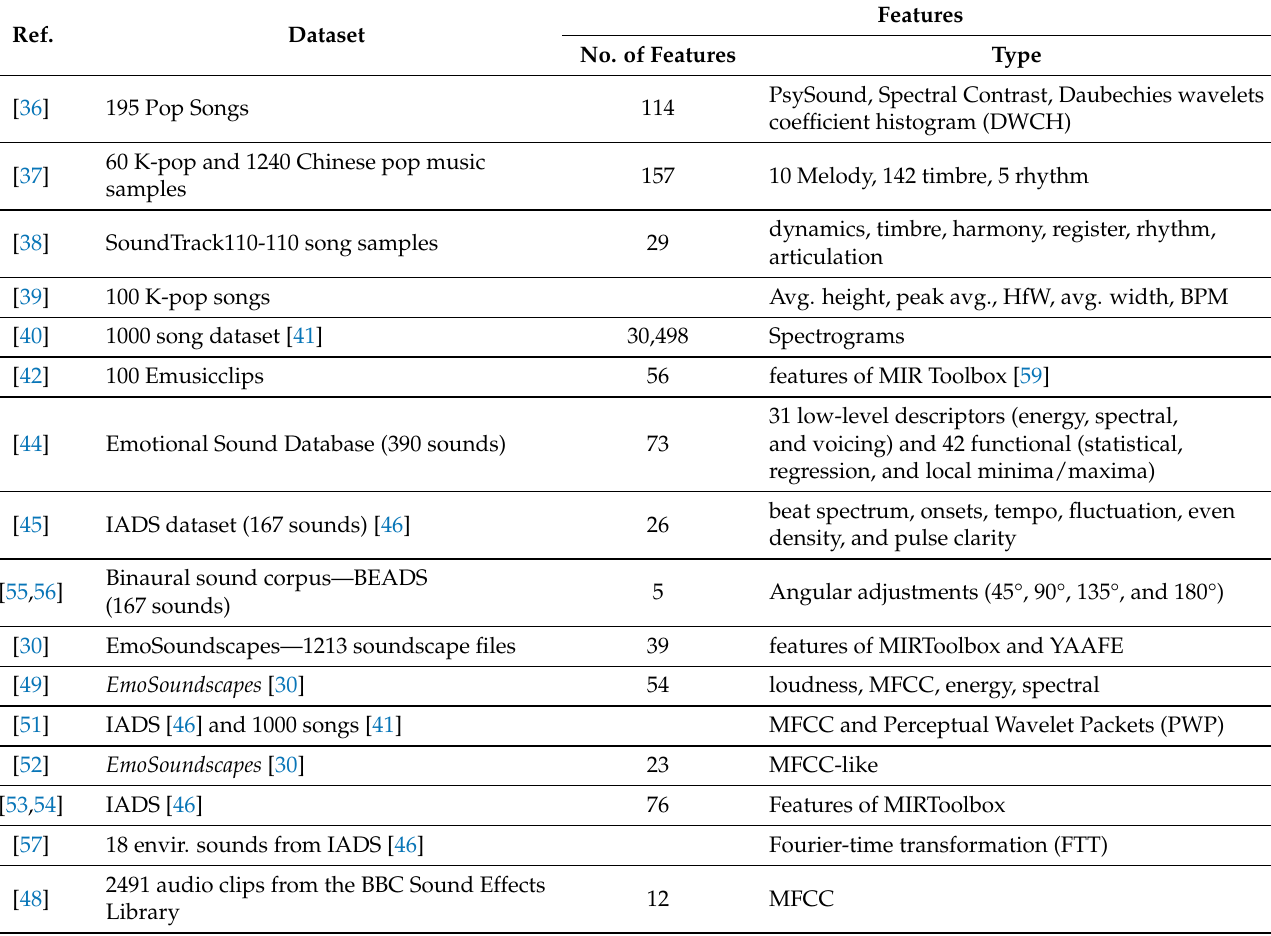
Table 2. Summary of features used for emotion recognition in the literature.